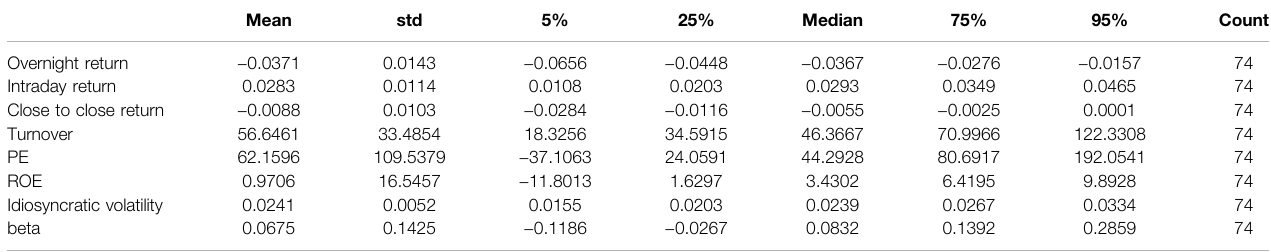
TABLE 1 | Descriptive statistics